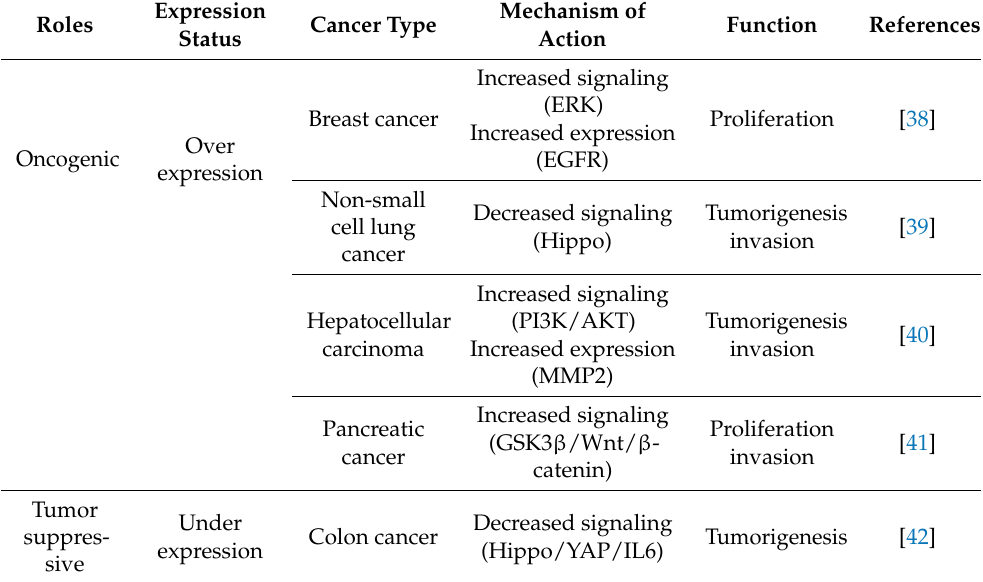
Table 2. Roles of RAB11A in